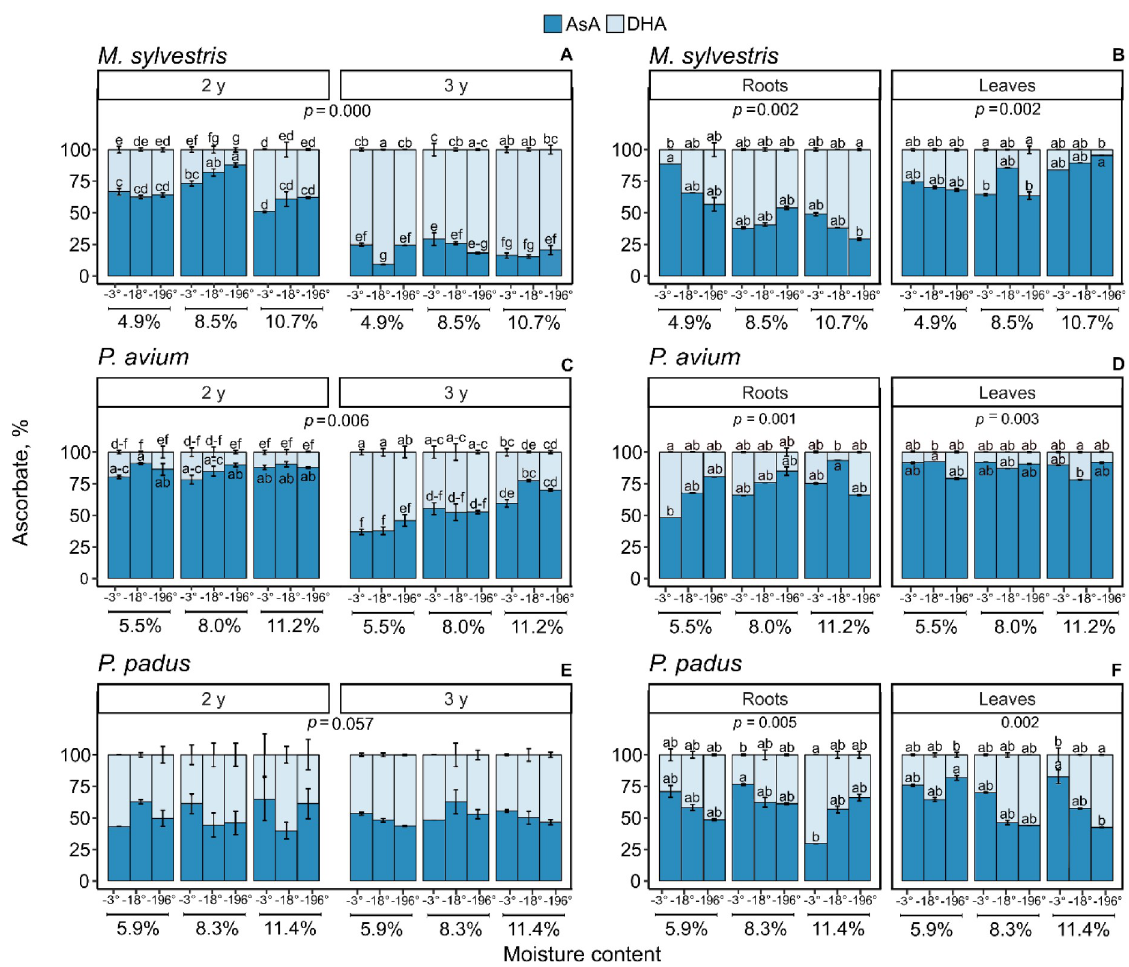
Fig 3. Changes in the reduced (AsA) and oxidized (DHA) form of ascorbate reported in germinated seeds (A, C, E) and 3-month-old seedlings derived from the seeds (B, D, F) of M . sylvestris (A, B), P . avium (C, D) and P . padus (E, F). In germinated seeds, the ratio of AsA and DHA between MC x storage temperature x storage time was compared. In 3-month seedlings, the ratio of ascorbate was measured in leaves and roots. Data are the means ± standard error obtained from three independent experiments with similar results. Statistically significant differences are indicated with different letters among the AsA and DHA (Tukey’s test for seeds and Dunn’s test for seedlings at p �